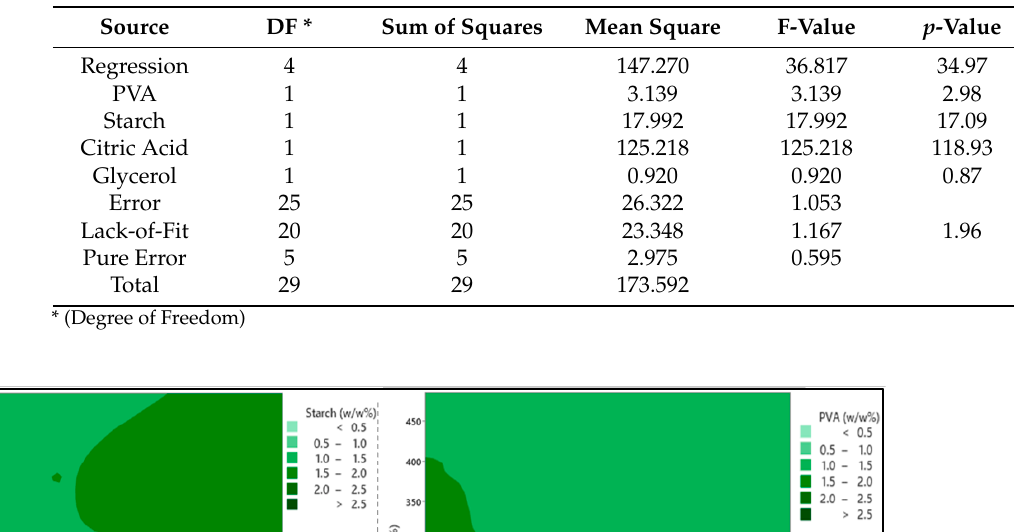
Table 4. Tensile strength output data, with a summary of the ANOVA.